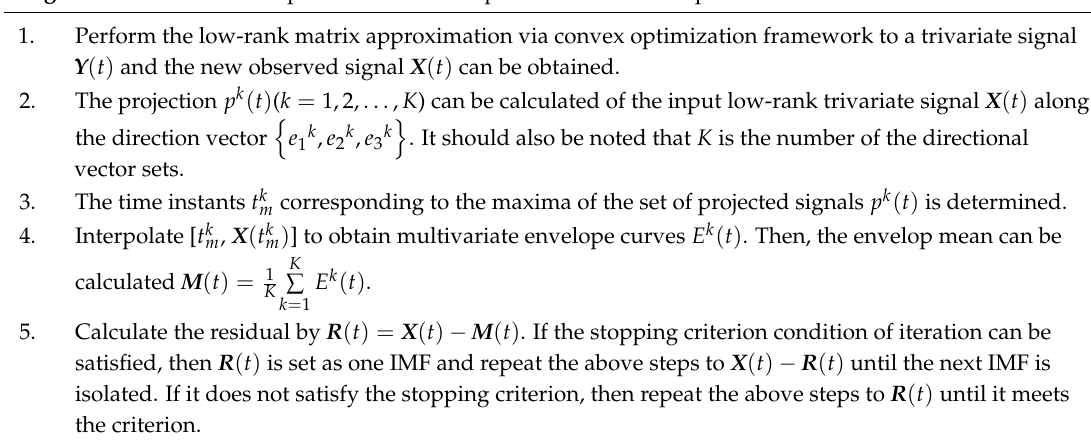
Algorithm 1. Trivariate empirical mode decomposition via convex